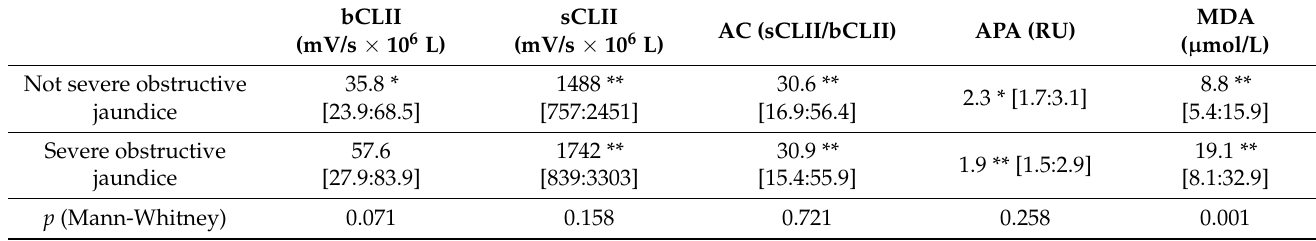
Table 5. Indicators of free radical processes in patients with obstructive jaundice of varying degrees of